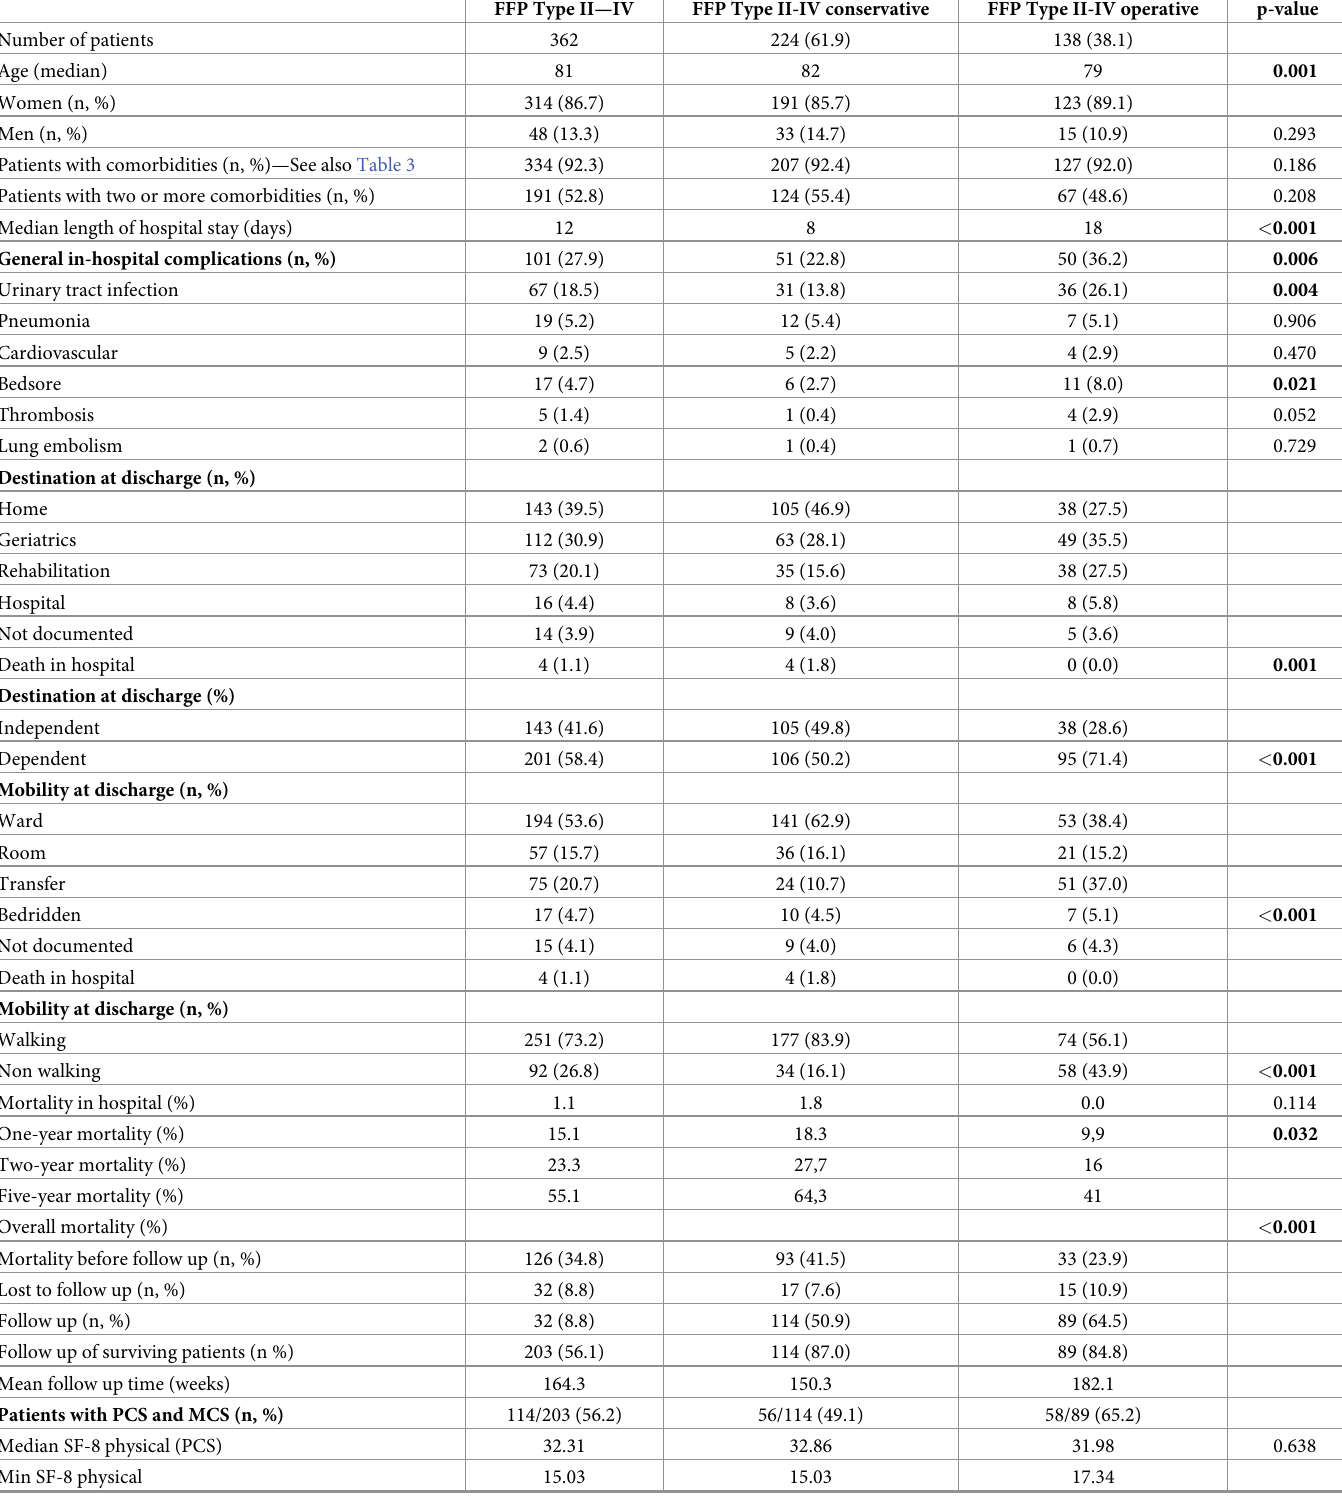
Table 2. Demographics, LoS, mortality and data at follow up of all patients, depending on type of